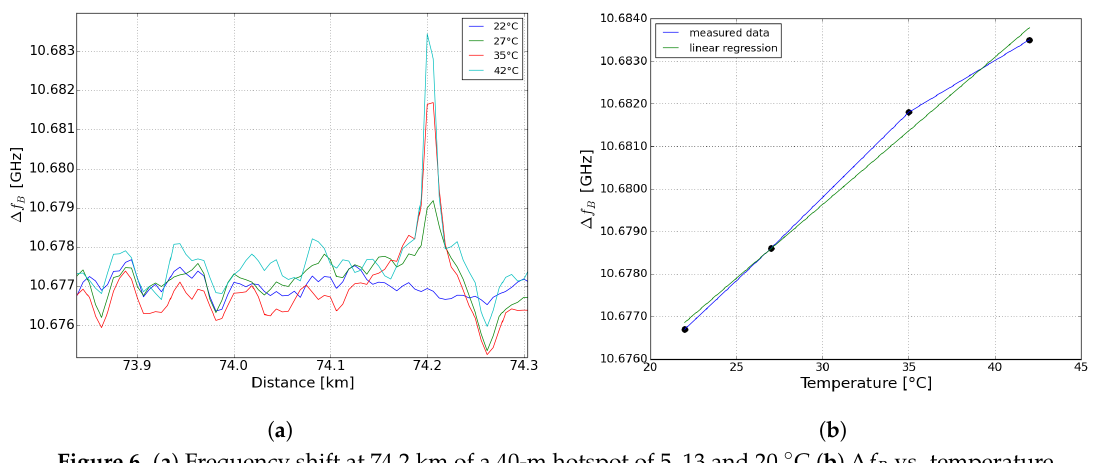
Figure 6. ( a ) Frequency shift at 74.2 km of a 40-m hotspot of 5, 13 and 20 ◦ C ( b ) ∆ f B vs. temperature, 0.34 MHz/ ◦ C extracted by linear regression from Figure 6b.